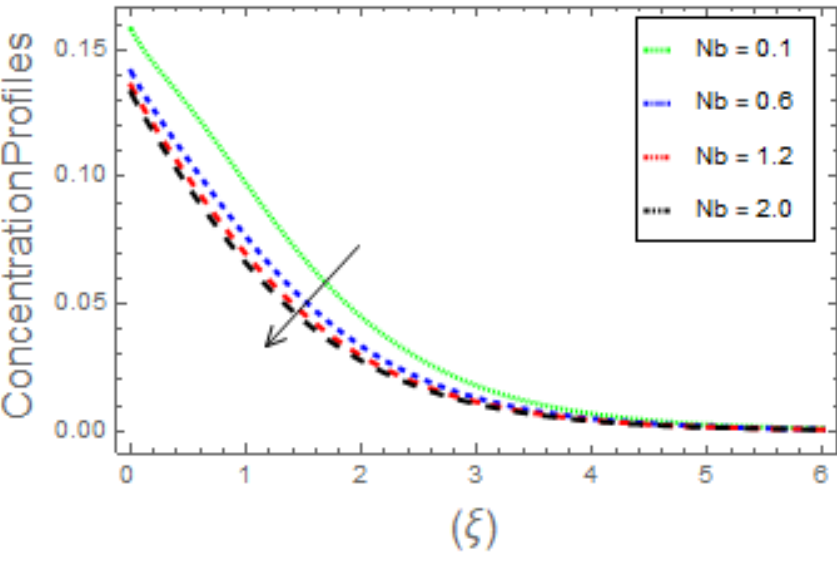
Figure 12. Variation in C due to Nb . Here, Figure 13 indicates variations in the energy curves subject to the Nt parameter. T ( ξ ) enhances through higher Nt . Physically, thermophoretic influence increases, as Nt is augmented. Such force facilitates the escape of small molecules from hotter to colder parts, and eventually, T ( ξ ) increases.